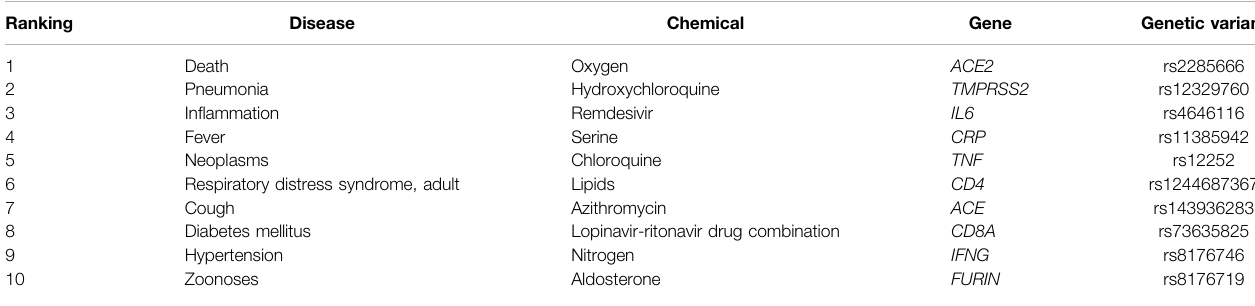
TABLE 5 | The top 10 entities ranked by the raw frequency. Ranking Disease